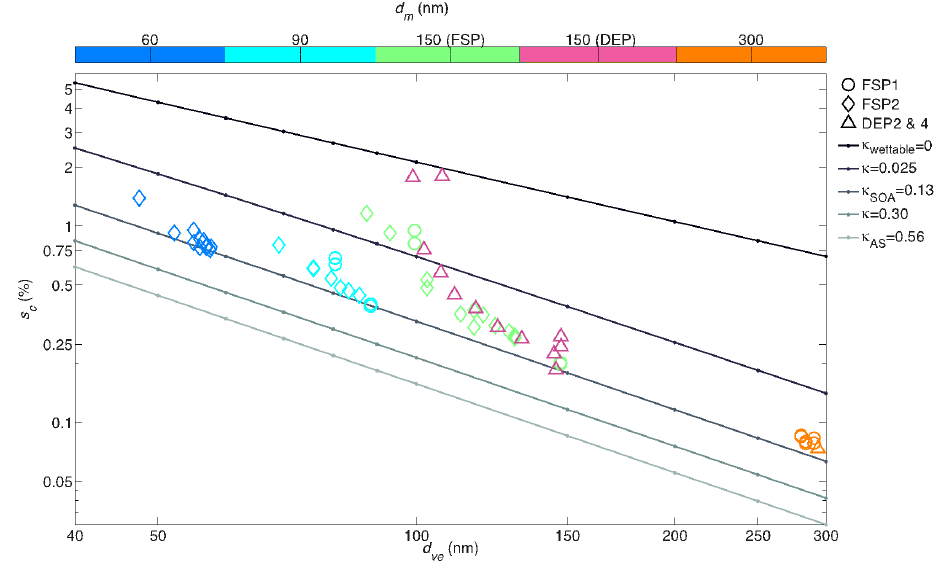
Figure 10. Empirical s c for different volume-equivalent diameters ( d ve ) , size-selected according to their mobility diameter ( d m ; colour coded) in comparison with calculated values of s c from κ -Köhler theory (greyscaling). Modelled values ranges from insoluble but wettable particles ( κ wettable = 0, black line) to AS particles ( κ AS ≈ 0.56, lightest grey) in the size range 40–300nm. Also plotted are modelled values for the κ value derived for the SOA appearing at the end of the experiments in this study ( κ SOA ≈ 0.13). Triangles denote coated diesel soot particles (DEP1, 2 and 4). Coated soot generator particles are represented by diamonds (FSP2) and circles (FSP1), differentiated due to their different primary particle sizes.